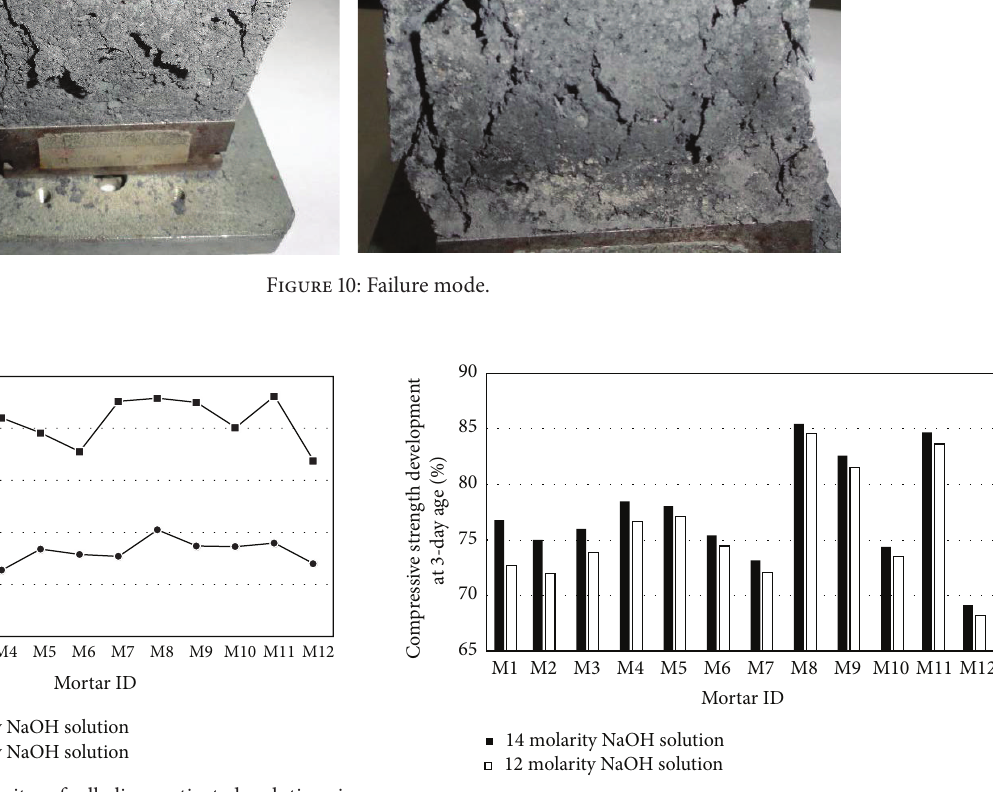
Figure 12: Development of early age compressive